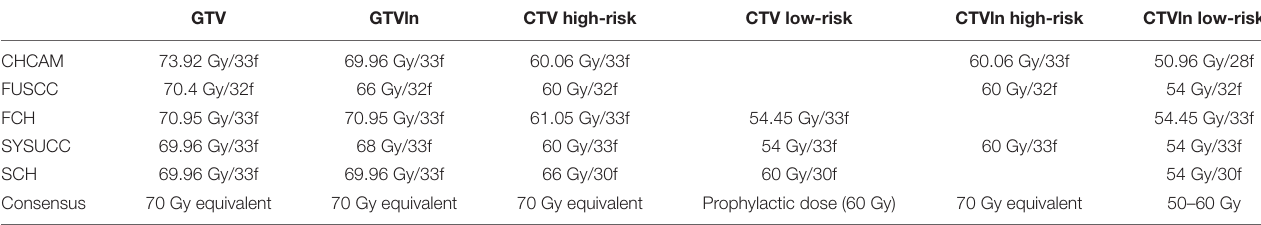
TABLE 1 | Different prescriptions and fractionations among the five centers.